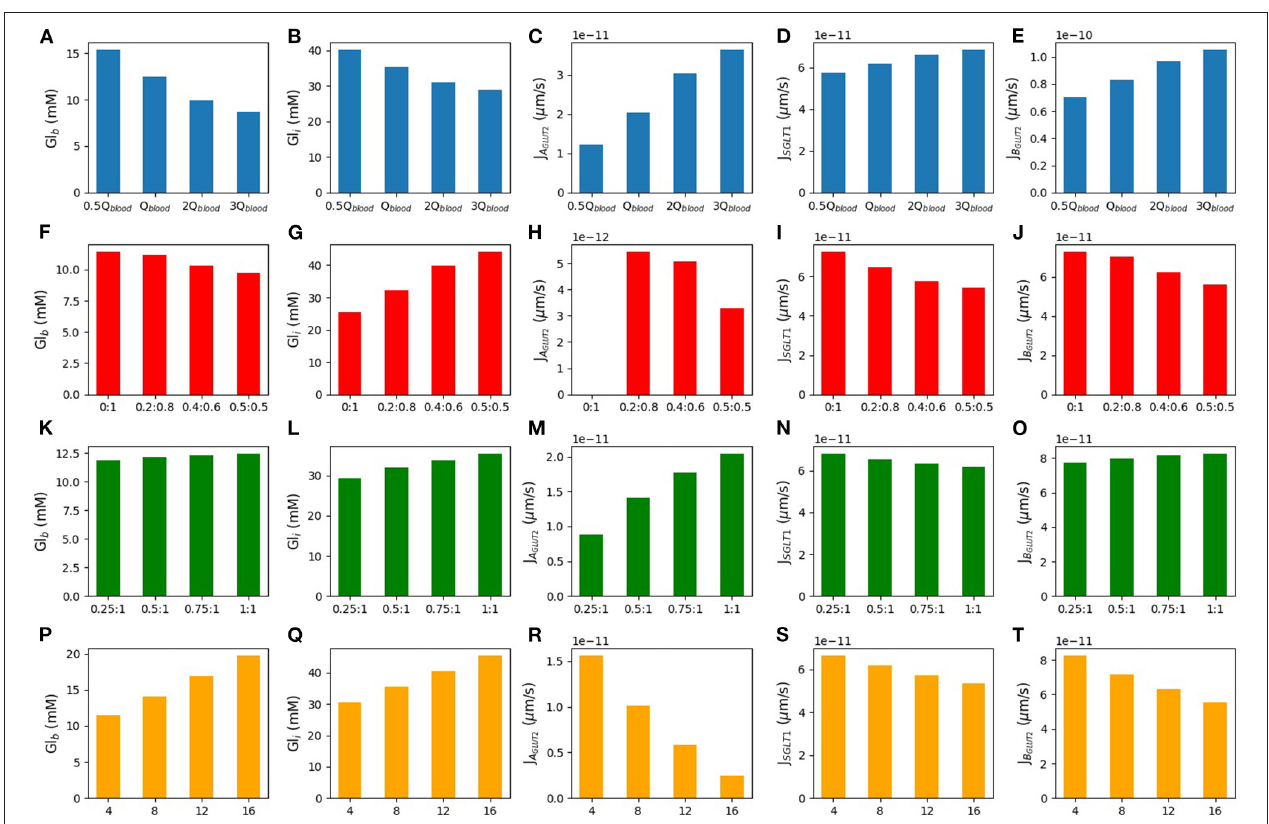
FIGURE 7 | Blood glucose concentration, intracellular glucose concentration, apical GLUT2 flux, SGLT1 flux, and basolateral GLUT2 flux under different conditions. The first row is the model response to different blood flow rates. Q blood = 10 − 17 m 3 /s is the baseline value of the blood flow rate (A–E) . The second row shows the response to variations in the inlet blood glucose concentration (F–J) . Rows three and four consider two different scenarios for GLUT2 translocation to the apical membrane. Row three shows simulations run under the assumption that apical GLUT2 is translocated from basolateral GLUT2. Different ratios between apical and basolateral GLUT2 are considered with the total number fixed (K–O) . Row four shows simulations run under the assumption that apical GLUT2 is translocated from intracellular vesicles. The number of basolateral GLUT2 is fixed and labels represent the fraction of total GLUT2 in the apical and basolateral membranes (P–T)